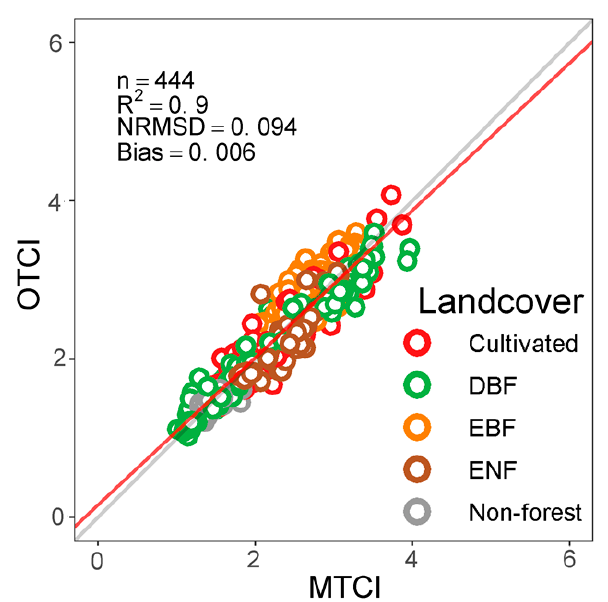
Figure 4. Comparison of monthly mean Sentinel-3 OTCI (2016 to 2019) and Envisat MTCI (2002 to 2012) values over the 37 validation sites (Table 4). Red and grey lines represent the modelled and 1:1 lines, respectively. OLCI data acquisition is up to 15 January 2020 (S3A orbital cycle 53).